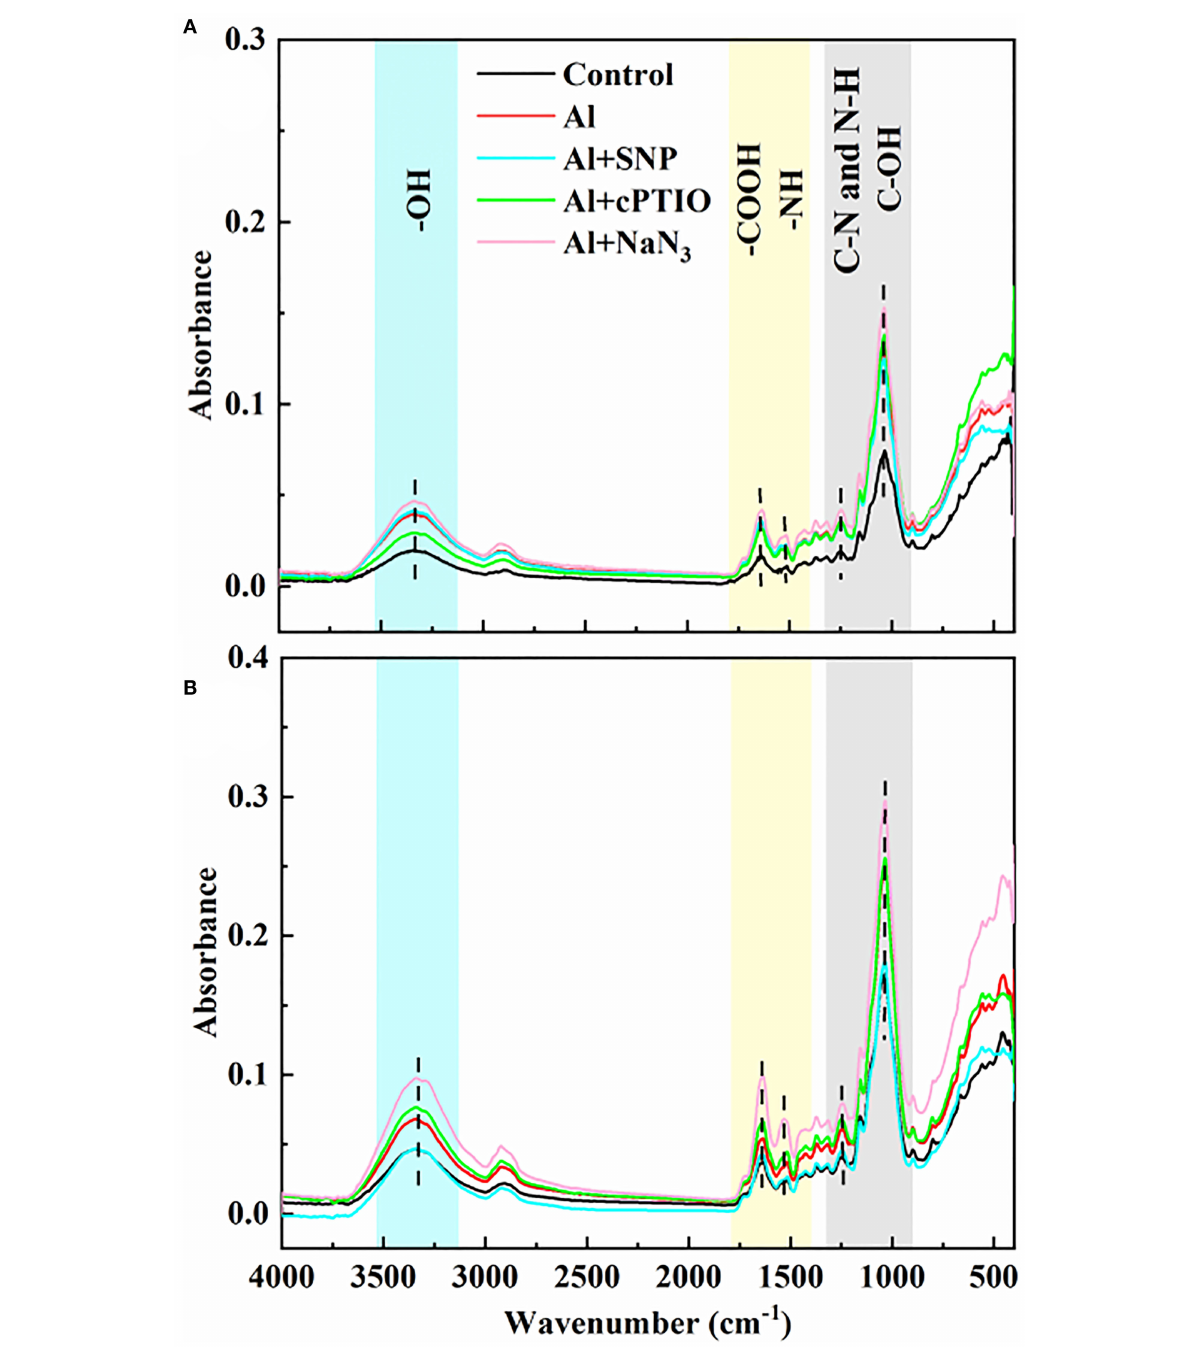
FIGURE3 The effect of exogenous NO and NO scavengers on FTIR spectra of cell wall in (A) Nipponbare and (B) Zhefu 802 root tips under Al